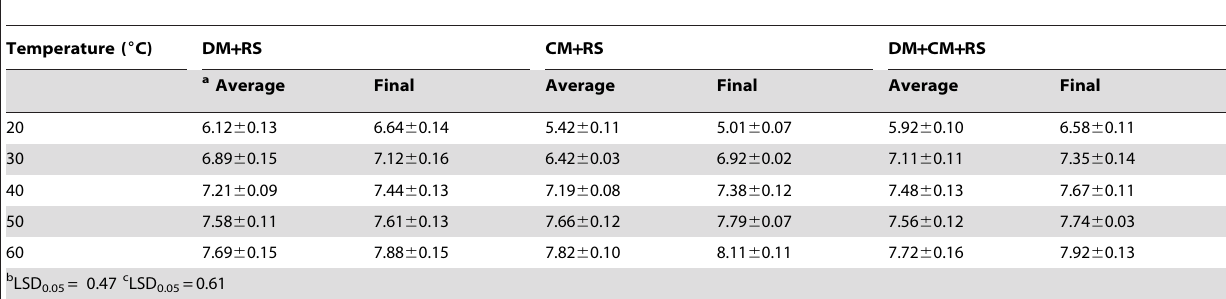
Table 2. Effects of temperature on pH value in anaerobic co-digestion with a C/N ratio of 25.